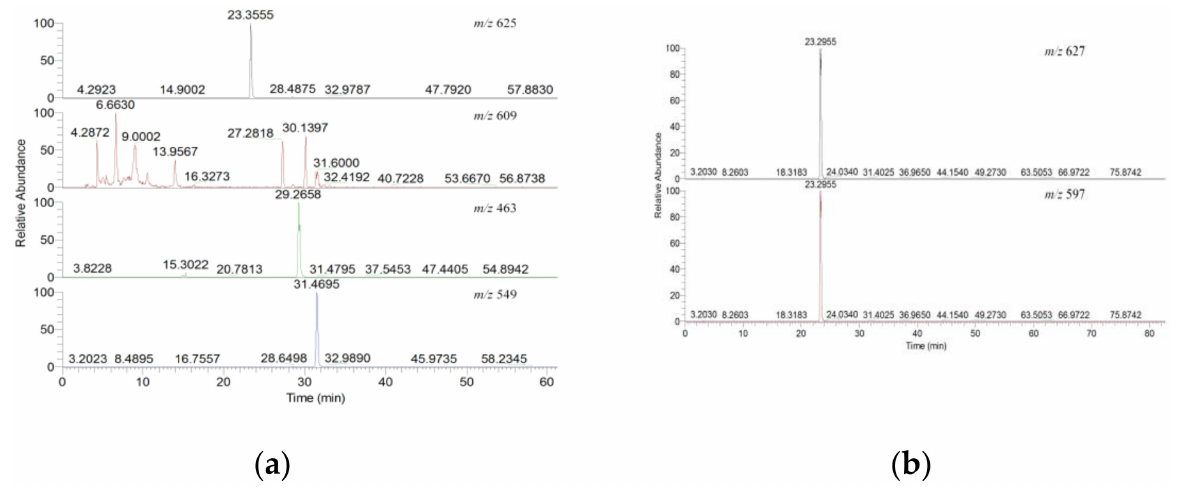
Figure 2. Screening of flavonoids through HPLC-MS/MS from extracts of okra. ( a ) negative ion scan ( m / z 625; m / z 609; m / z 463; m / z 549). ( b ) positive ion scan ( m / z 627; m / z